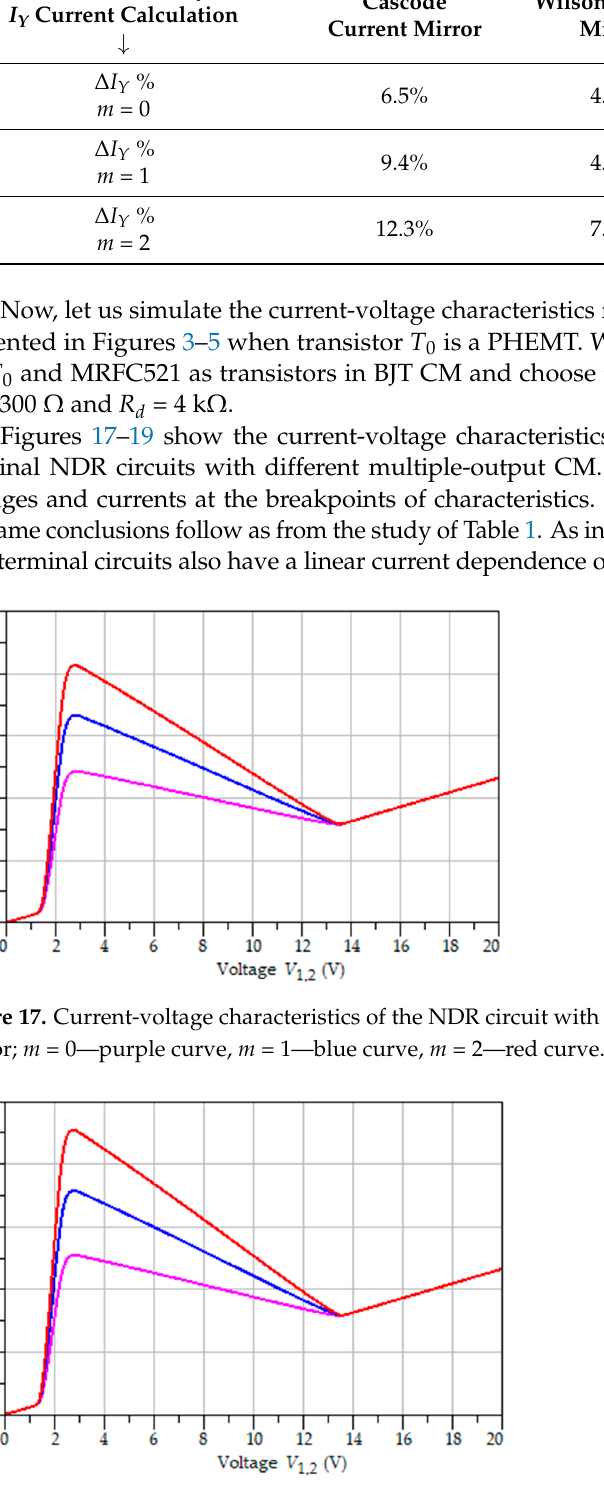
Figure 19. Current-voltage characteristics of the NDR circuit with multiple-output improved Wilson current mirror; m = 0—purple curve, m = 1—blue curve, m = 2—red curve. We also calculate the current I 1 at voltages V X , V Y , and V Z using Equations (3), (5) and (7) with the following data of transistors ATF34143 [54] and MRFC521: b = 0.24 A/V 2 , V TH = –0.95 V, α = 4 V –1 , λ = 0.09 V –1 , h FE = 50, V A = 15 V, V EB3 = 0.7 V. The values of resistors R c and R d are similar to those used in simulation. Tables 5 and 6 show the calculated currents I Y and I Z and the relative accuracy of the I Y current calculation Δ I Y %. The conclusions concerning the accuracy of the current I Y calculation for Table 6 are the same as those for Table 3. We should note that the accuracy of calculating the current I D by Formula (17) is quite high. Indeed, for all two-terminal NDR circuits at V Y = 2.8 V, the current I D (simulated) = 2.79 mA, and the current I D (calculated) = 2.67 mA. Therefore, Δ I D % = –4.5 %, where Δ I D % is the relative accuracy of calculating the current I D by formula (calculated) (27) Table 4. Simulated parameters of current-voltage characteristics for different two-terminal NDR circuits ( T 0 —PHEMT). Type of NDR Circuit → Two-Terminal NDR Circuit with Multiple-Output Parameter of I–V Charac- teristic ↓